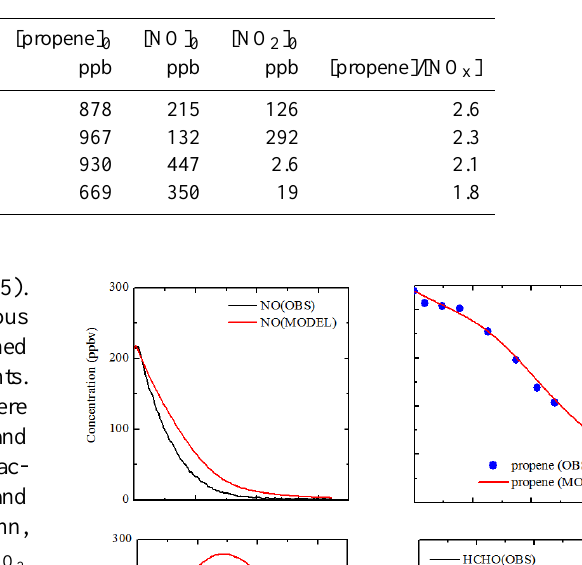
Table 4. Summary of initial conditions for propene–NO x –air irradiation experiments.